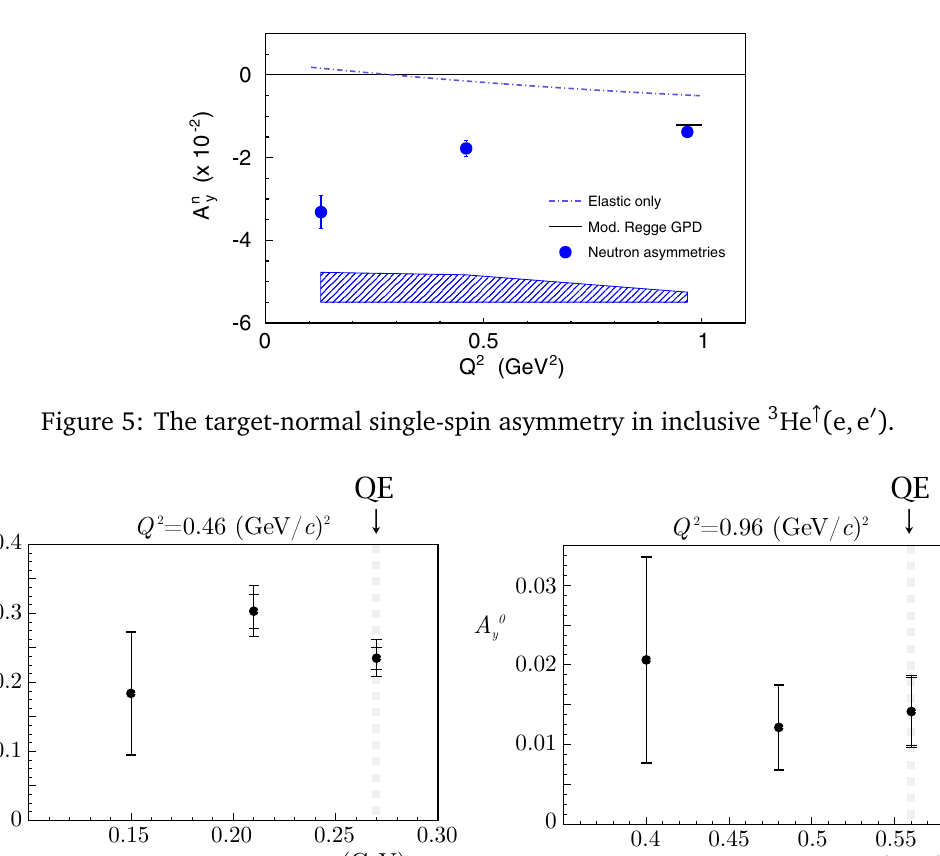
Table 5: Experimental results for A 0 y scaled by 10 − 2 .